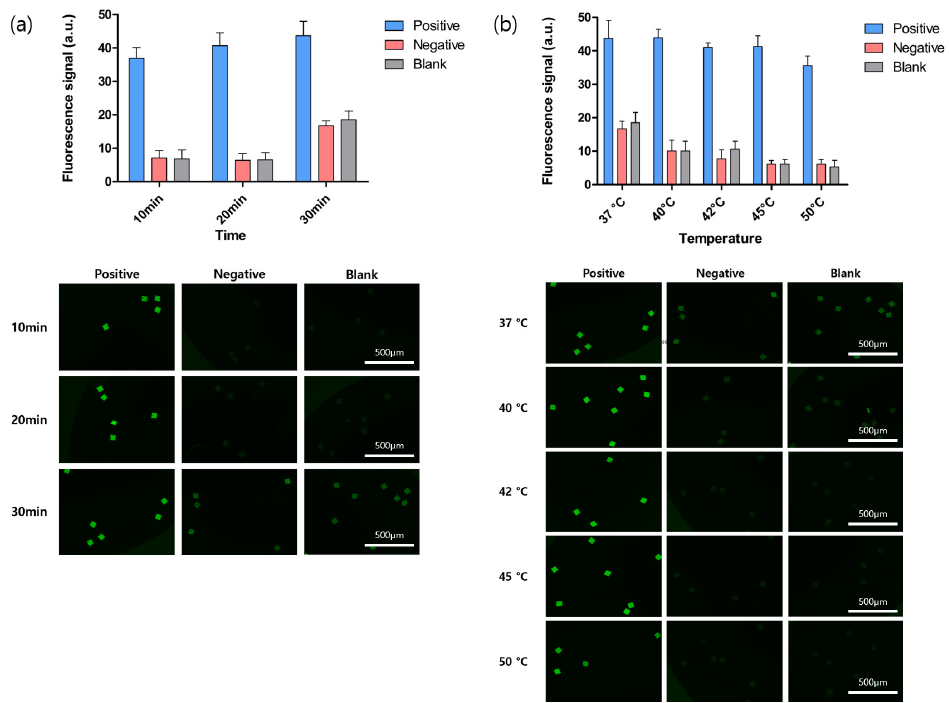
Figure 2. Optimization of BREP assay conditions. ( a ) Optimization of assay duration conducted at 45 ◦ C with 10 pmol/mL of synthetic barcode for positive sample, 10 pmol/mL of barcode probe for negative sample, and deionized water as blank. Fluorescence signal intensity at 10, 20, and 30 min. ( b ) Temperature optimization was conducted with 10 pmol/mL of synthetic barcode for positive sample, 10 pmol/mL of barcode probe for negative sample, and deionized water as blank, with the assay duration being 20 min. Fluorescence signal intensity at 37, 40, 42, 45, and 50 ◦ C. Bar graph showing mean values of fluorescence signal intensity. Error bars represent standard deviation (n =